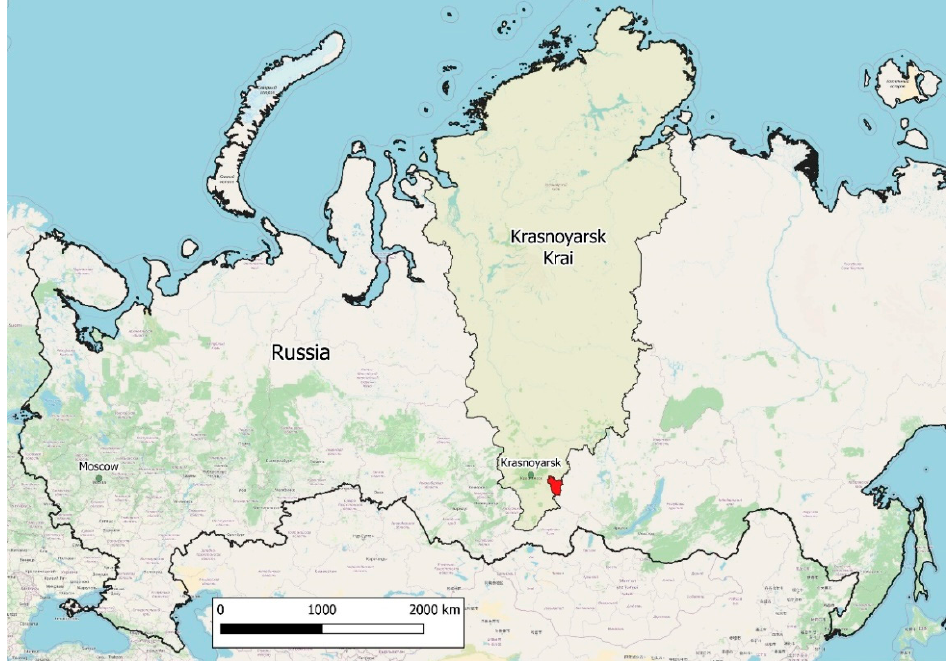
Figure 1. Study area location.